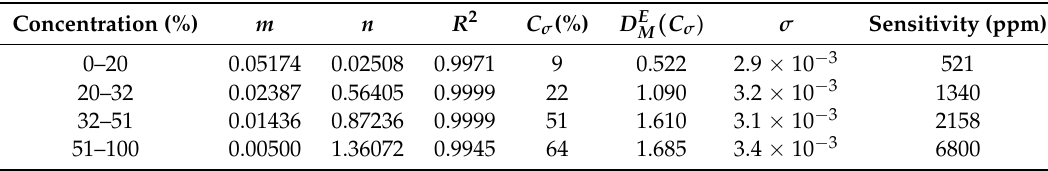
Table 1. Sensor sensitivity for different concentration